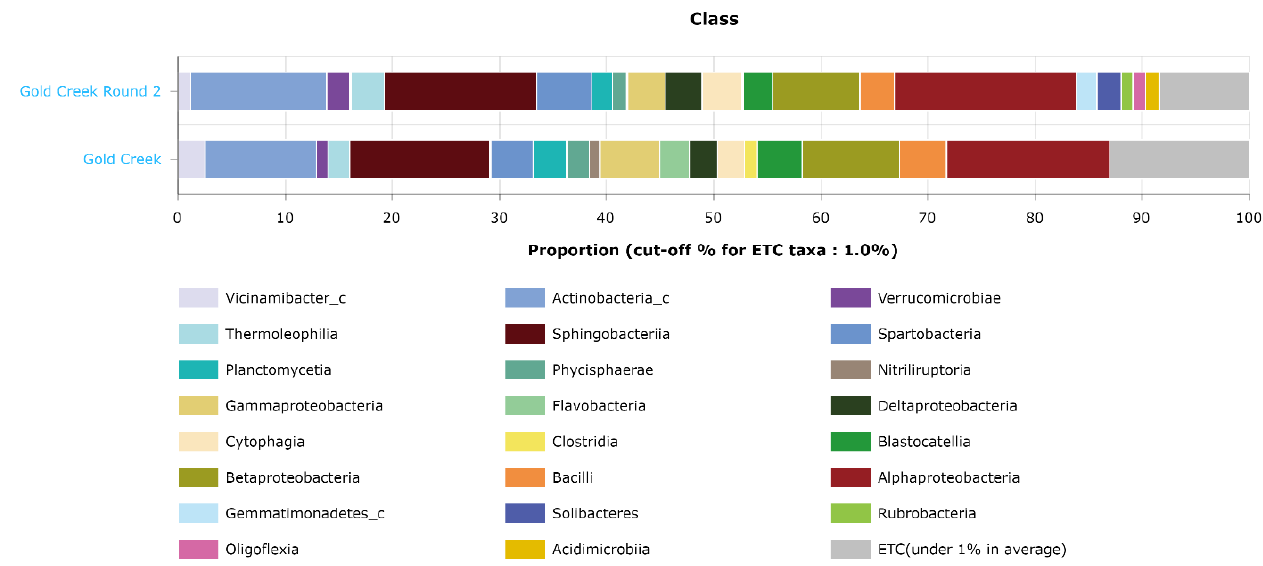
Figure 7. Comparison of the taxonomic composition of the winter sequences versus the summer sequences at the phylum level using EZBioCloud MTP.